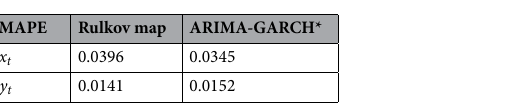
Table 7. MAPE of the Rulkov and the ARIMA-GARCH*